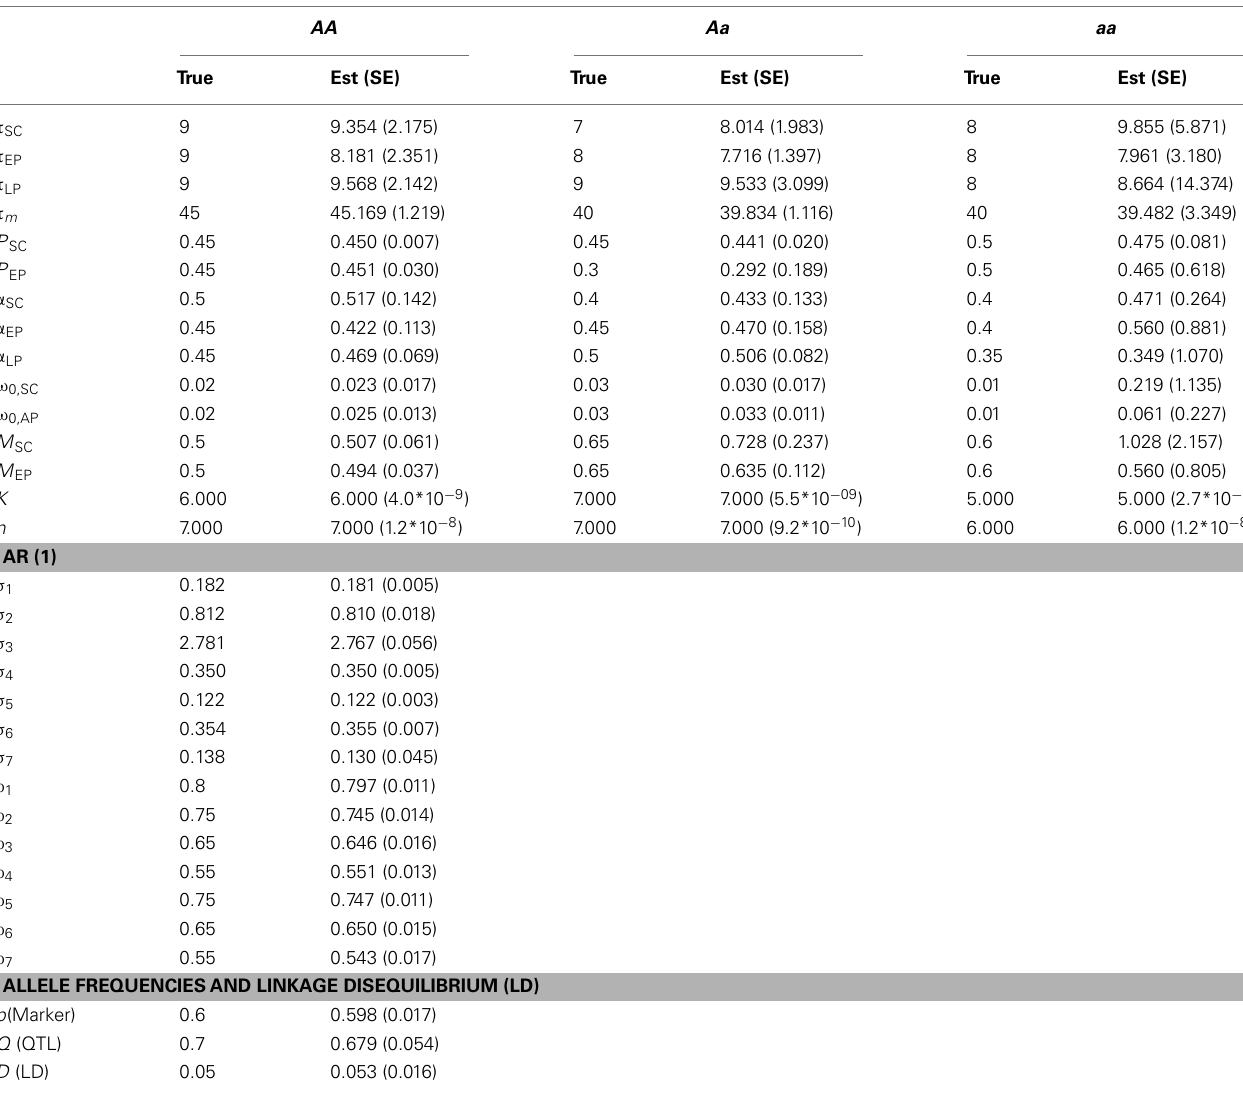
Table 1 |The estimation of parameters by a dynamic model for mapping cancer stem cell proliferation from a simulated mapping population of 500 individuals by assuming heritability H 2 = 0.1